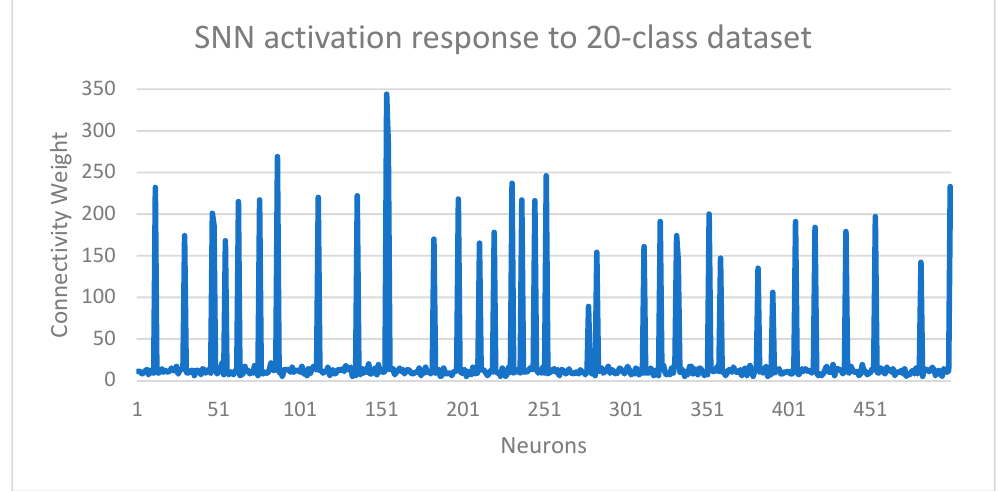
Figure 7. Activation pattern among the neuron population in the SNN. The response shows the resultant changes in connectivity weights for 500 neurons in the network.